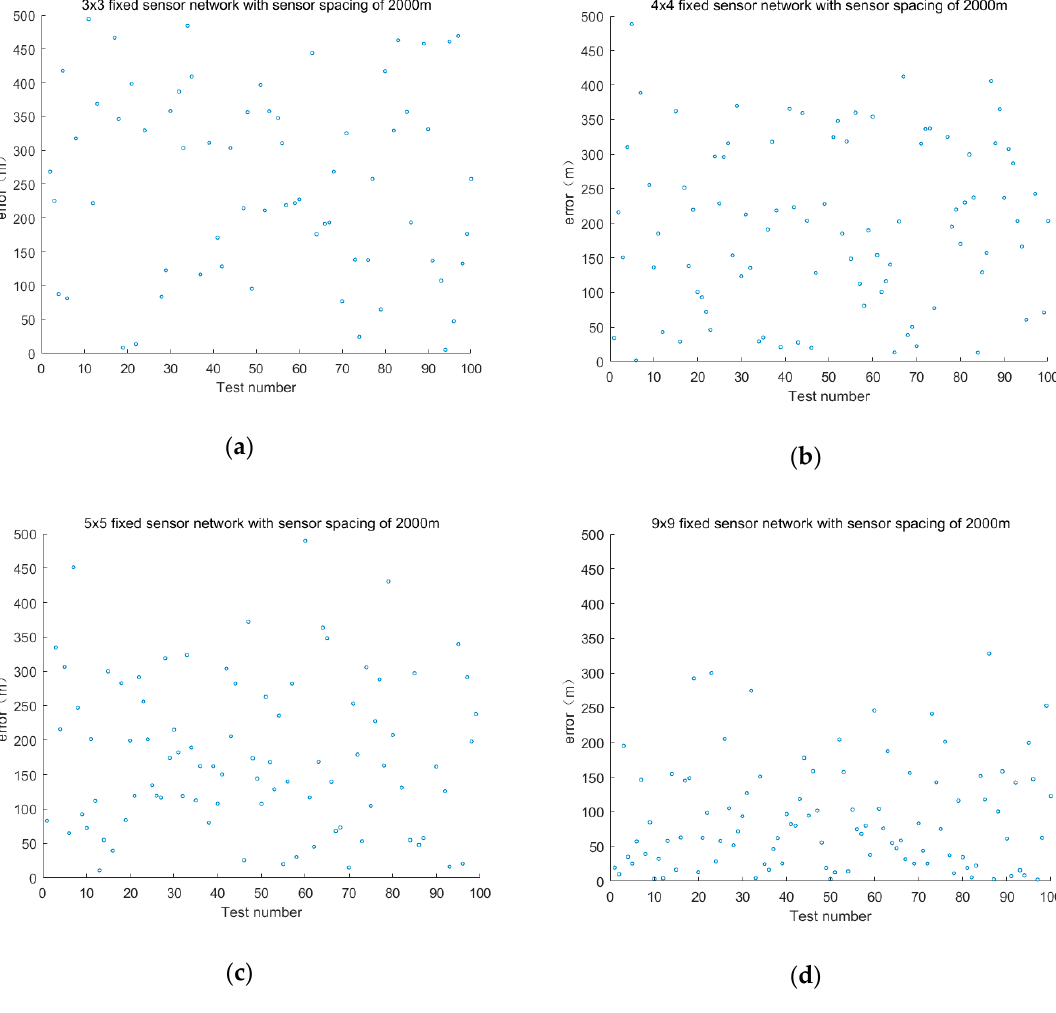
Figure 7. Positioning error of fixed sensor networks with different layouts at 2000 m intervals.